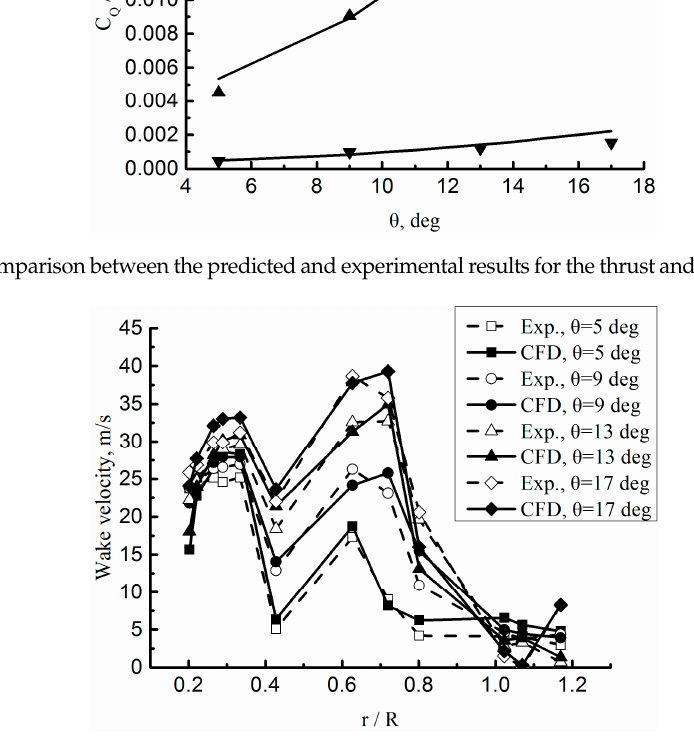
Table 3. Details of the three meshes for independence examination.